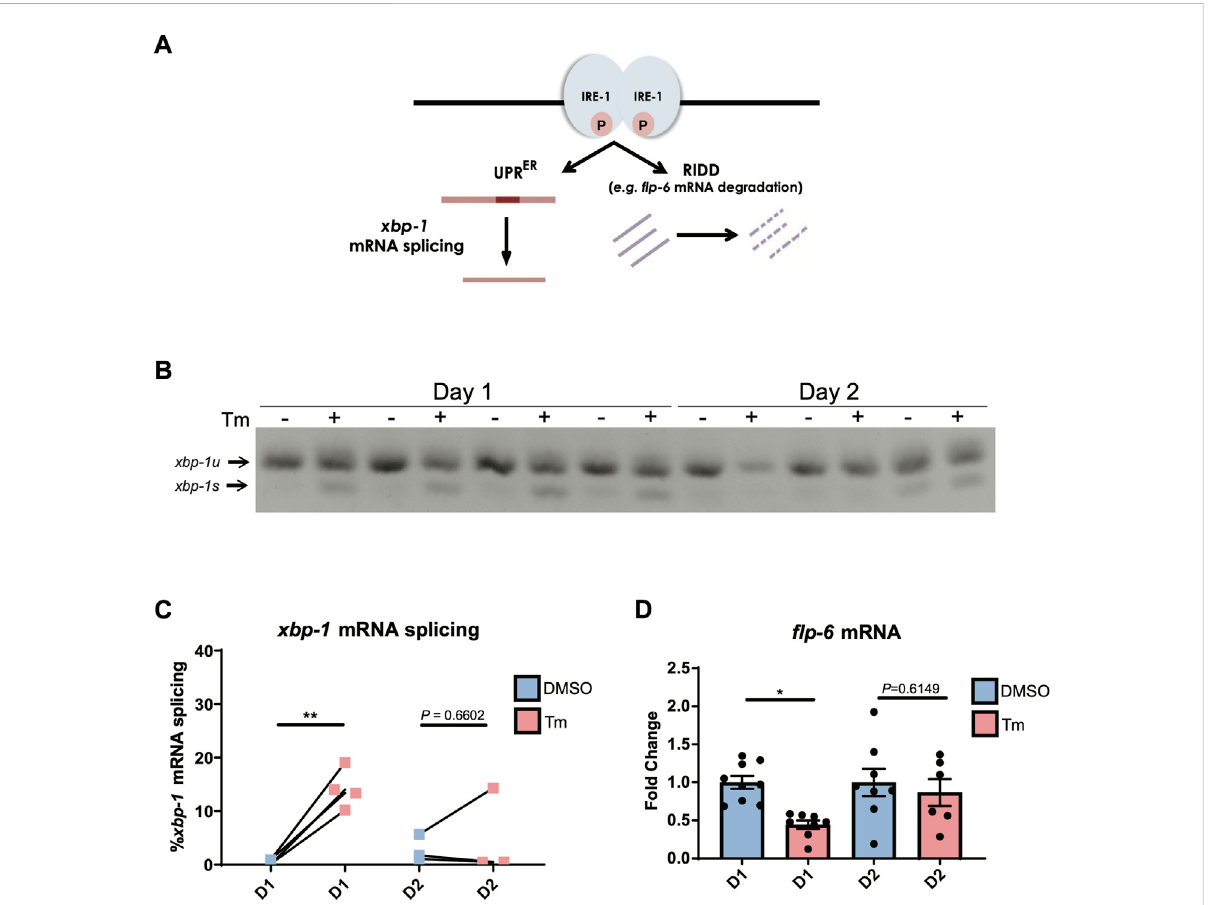
FIGURE 2 IRE-1 endoribonuclease activities are downregulated during the fi rst day of adulthood as animals enter the reproductive period. (A) Schematic representation of IRE-1 endoribonuclease action during ER stress. (B,C) xbp-1 mRNA splicing was measured by qRT-PCR in animals after 6 h of tunicamycin (Tm) or DMSO treatment. ** p < 0.01. Unpaired t -test (DMSO vs. Tm) (D) The mRNA levels of fl p-6 — a RIDD target in C. elegans — were measuredbyqRT-PCRinanimalsatDay1orDay2ofadulthood afterbeingtreated withtunicamycin (Tm)orDMSO for6 h* p < 0.05, Unpaired t -test (DMSO vs.